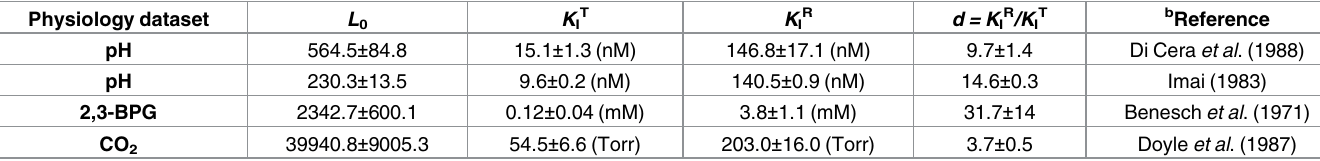
a The MWC allosteric parameters for the hemoglobinpH, CO 2 and 2,3-BPG datasets were derived assuming a non-exclusive ligand binding mode, as described by the equation reported in Fig 3 legend and in reference [12]. L 0 corresponds to the [ T ]/[ R ] ratio in the absence of allosteric effector (S1 Fig). K IT and K IR respectively correspond to the allosteric inhibitor affinity towards the T and R hemoglobinstates and d to the ratio between the two affinities. b The full reference is indicated in S2 Table, right-most